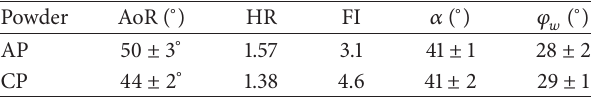
Table 2: Measured flow properties of alumina and ceramic powder.